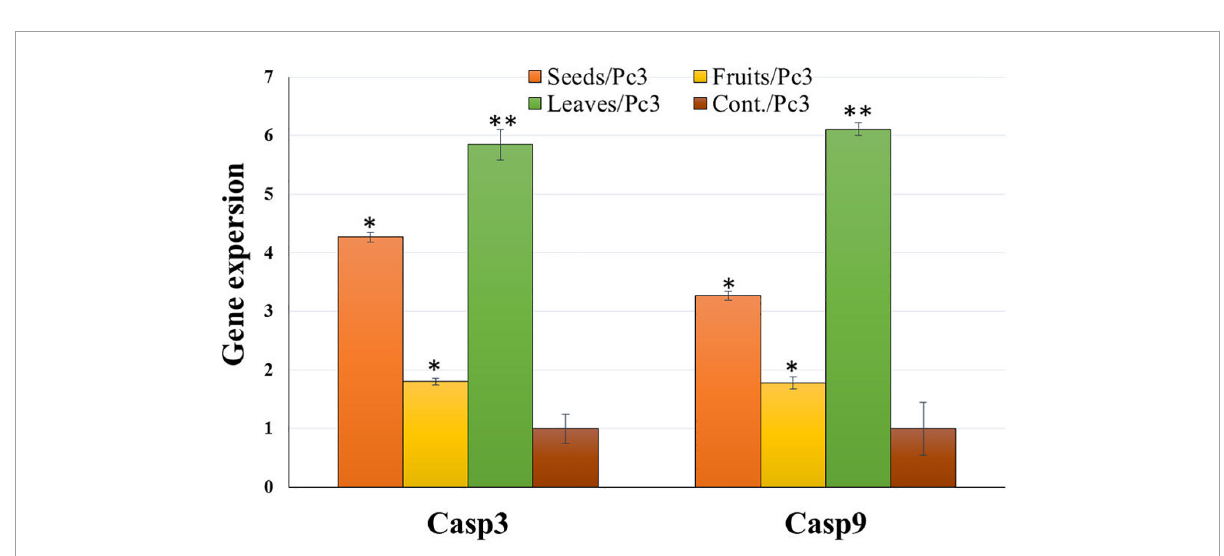
FIGURE13 Effect of leaf, seed, and fruit extracts on Casp3 and Casp9 gene expression in the pancreatic cancer cell (Pc3). * P -value was considered statistically significant ( P < 0.05) and ** P -value was considered highly significant ( P <